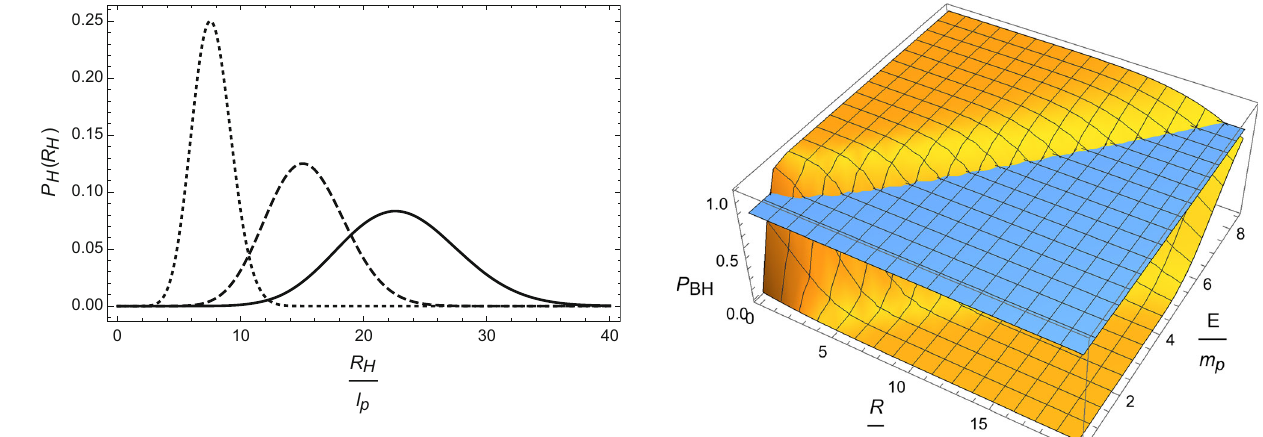
Fig. 1 Probabilitydensityforthehorizontobelocatedonthesphereof √ radius r = R H , for a total energy E = 2 2 m p (cid:11) 2 . 8 m p (dotted line), √ √ Fig. 2 Probability for two shells of equal radial momenta to be a black E = 4 2 m p (cid:11) 5 . 7 m p (dashed line) and E = 6 2 m p (cid:11) 8 . 5 m p hole as a function of the radius R and the total energy E (in Planck (continuous line). Curves peak at values larger than R H ∼ 2 E units). The blue plane delimits the region above which the probability P BH > 0 .